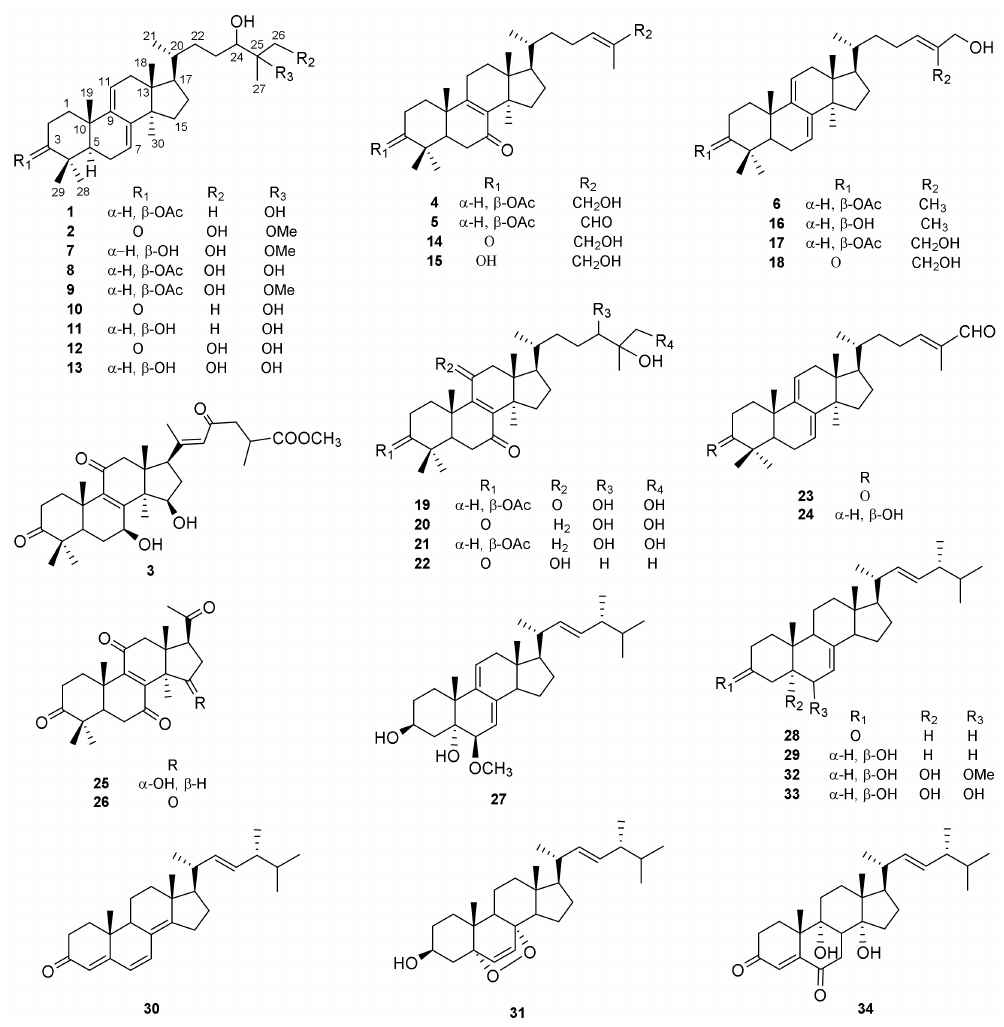
Figure 1. The structures of compounds 1 – 34